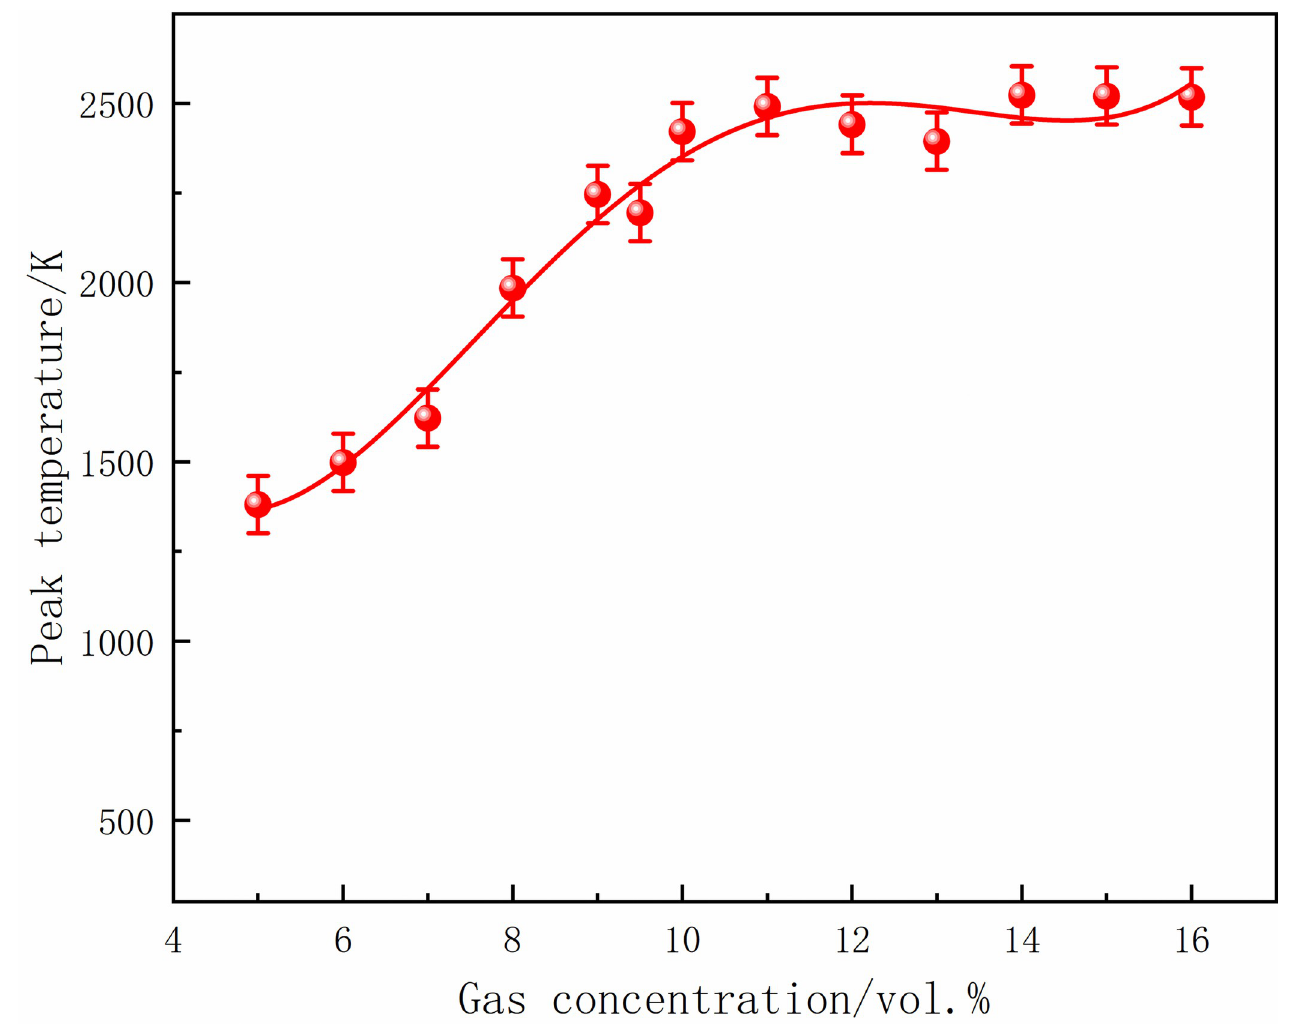
Fig 27. Temperature peaks at different local gas concentrations at the monitoring point